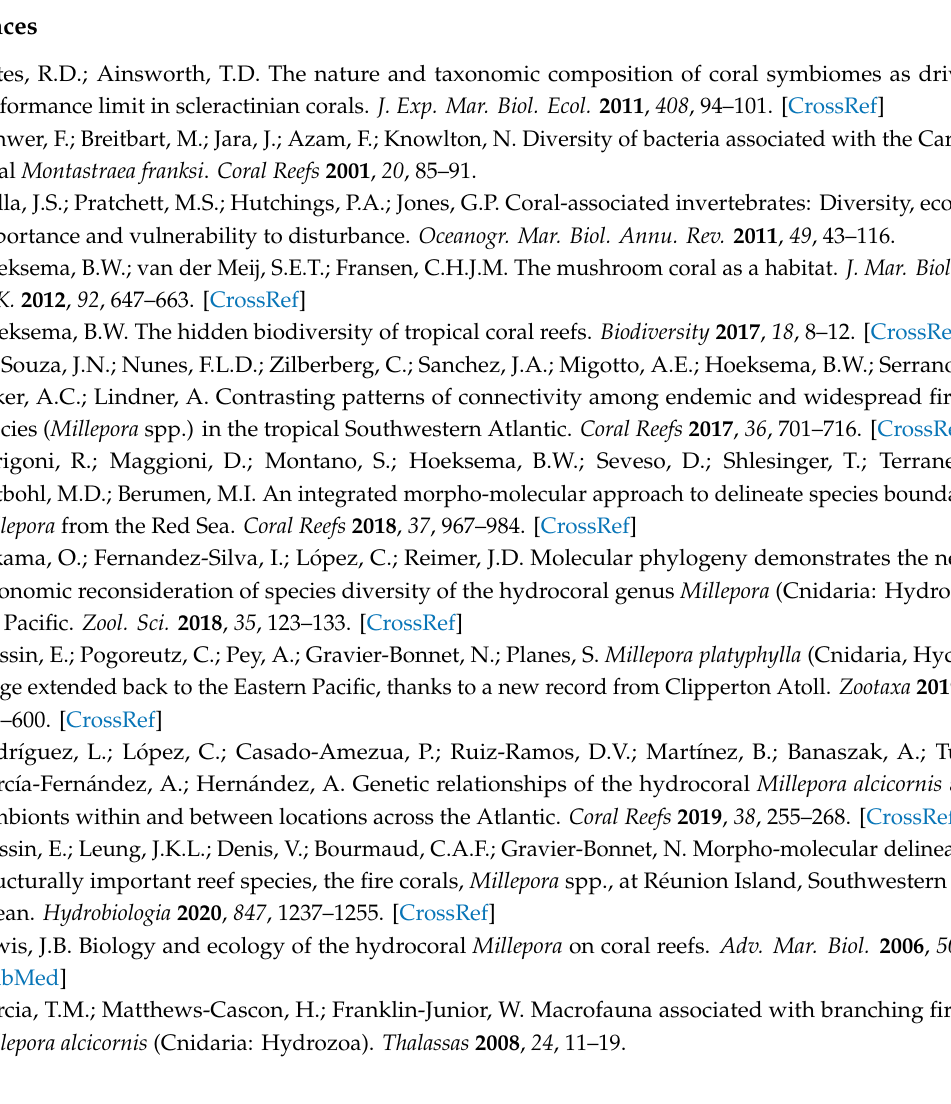
Figure S1. Stylaster rosesus in its natural habitat. Figure S2. Di ff erent growth morphologies of M. alcicornis . Table S1. List of locations and number of associations recorded for each site